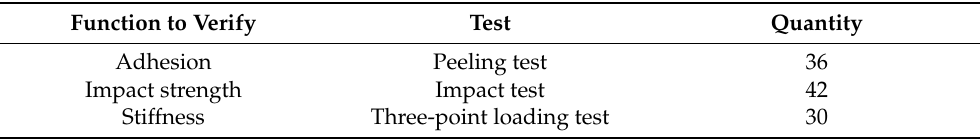
Table 7. Test performed to different composites.